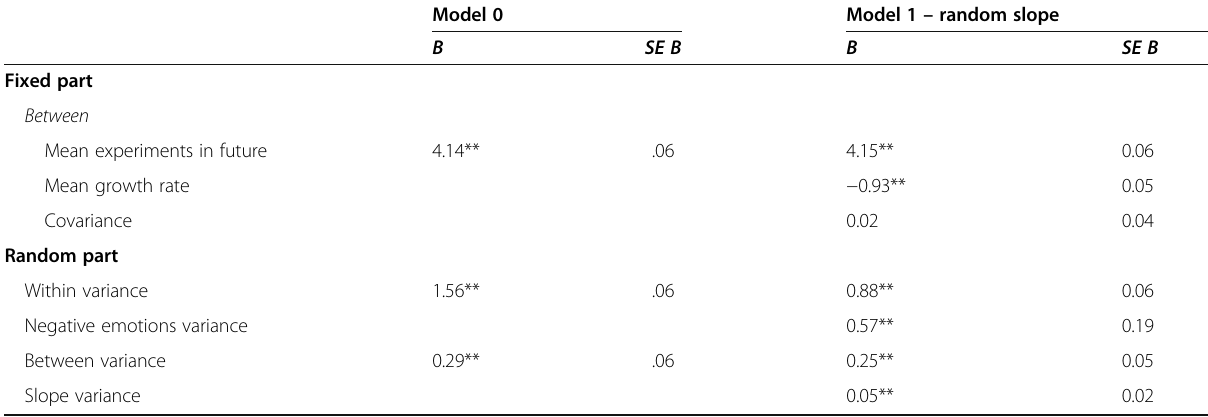
Table 3 Random slope model for pre-service teachers ’ momentary intentions to apply the experiments in the future